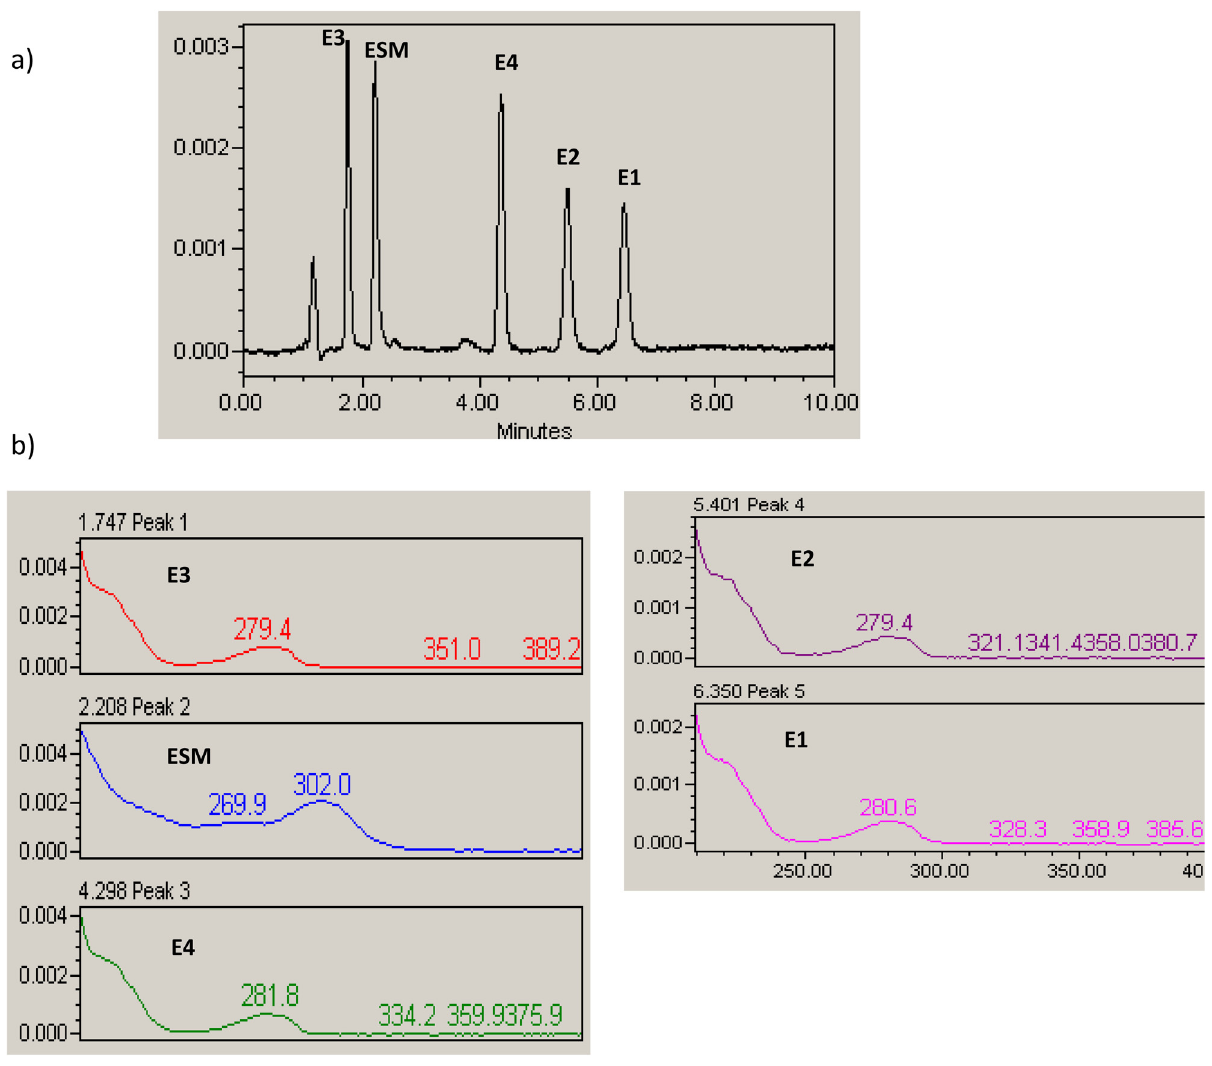
Figure 2: A typical HPLC chromatogram of a standard mixture of 10 µg/mL of each of the studied estrogens ( a ) , estriol ( E3 ) , 17 α - ethinylestradiol ( E4 ) , 17 β estradiol ( E2 ) , and estrone ( E1 ) , with the internal standard ( IS ) ESM, 10 µg/mL. The absorption spectra of the studied estrogens and the IS are also shown ( b ) . The mobile phase consisted of acetonitrile/water mixture in the ratio of 50:50, v/v and adjusted at the fl ow rate of 1